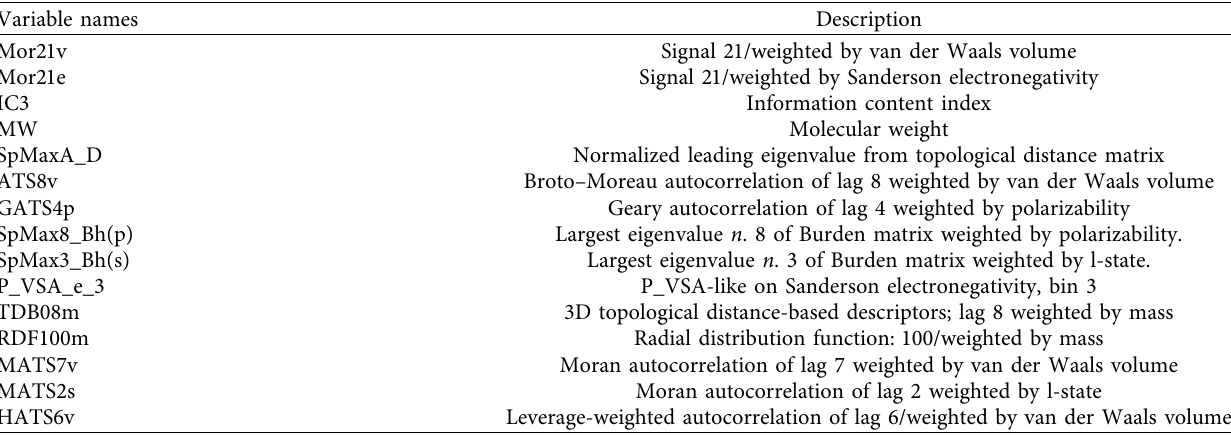
Table 3: Description of the variable.